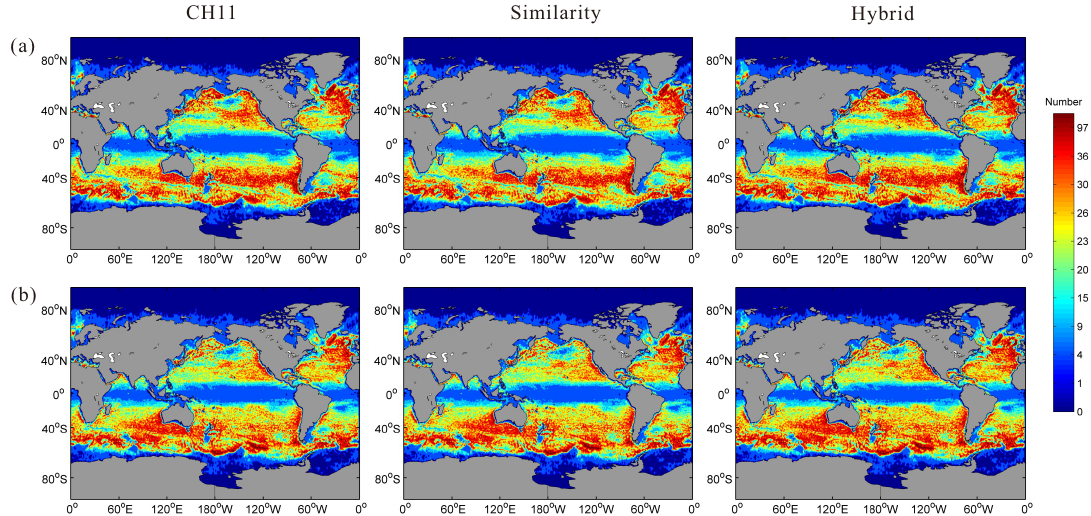
Figure 8. Comparison of the geographical distribution of ( a ) Anticyclonic and ( b ) Cyclonic eddy frequencies along eddy trajectories determined using the three tracking methods in each 1 ◦ × 1 ◦ region.